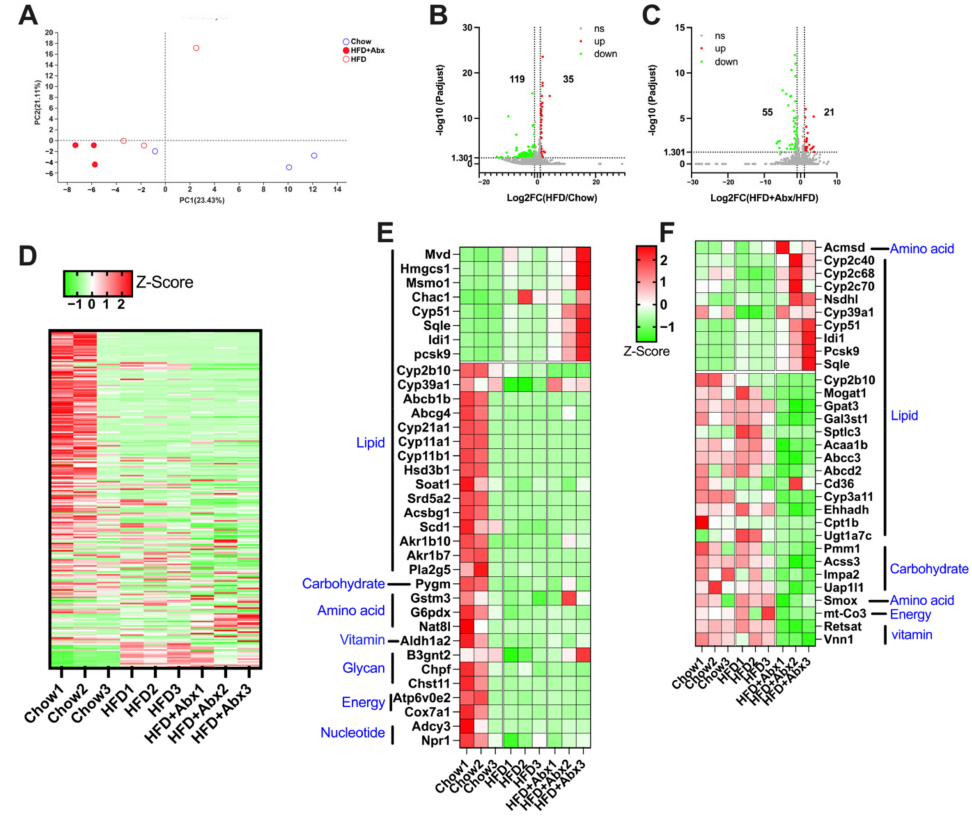
Figure 7. Gut microbiota depletion altered liver gene expression in HFD-fed mice. ( A ) PCA score plots for discriminating the liver gene expression from Chow, HFD, and HFD+Abx groups; ( B ) volcano plot of DEGs between mice fed a chow diet and HFD; ( C ) volcano plot of DEGs between mice with and without Abx treatment when fed an HFD; ( D ) heatmap of all the DEGs altered by HFD and Abx treatment; ( E ) heatmap of DEGs related to metabolism between mice fed a Chow diet and HFD; ( F ) heatmap of DEGs related to metabolism between mice with and without Abx treatment when fed an HFD. DEGs, differentially expressed